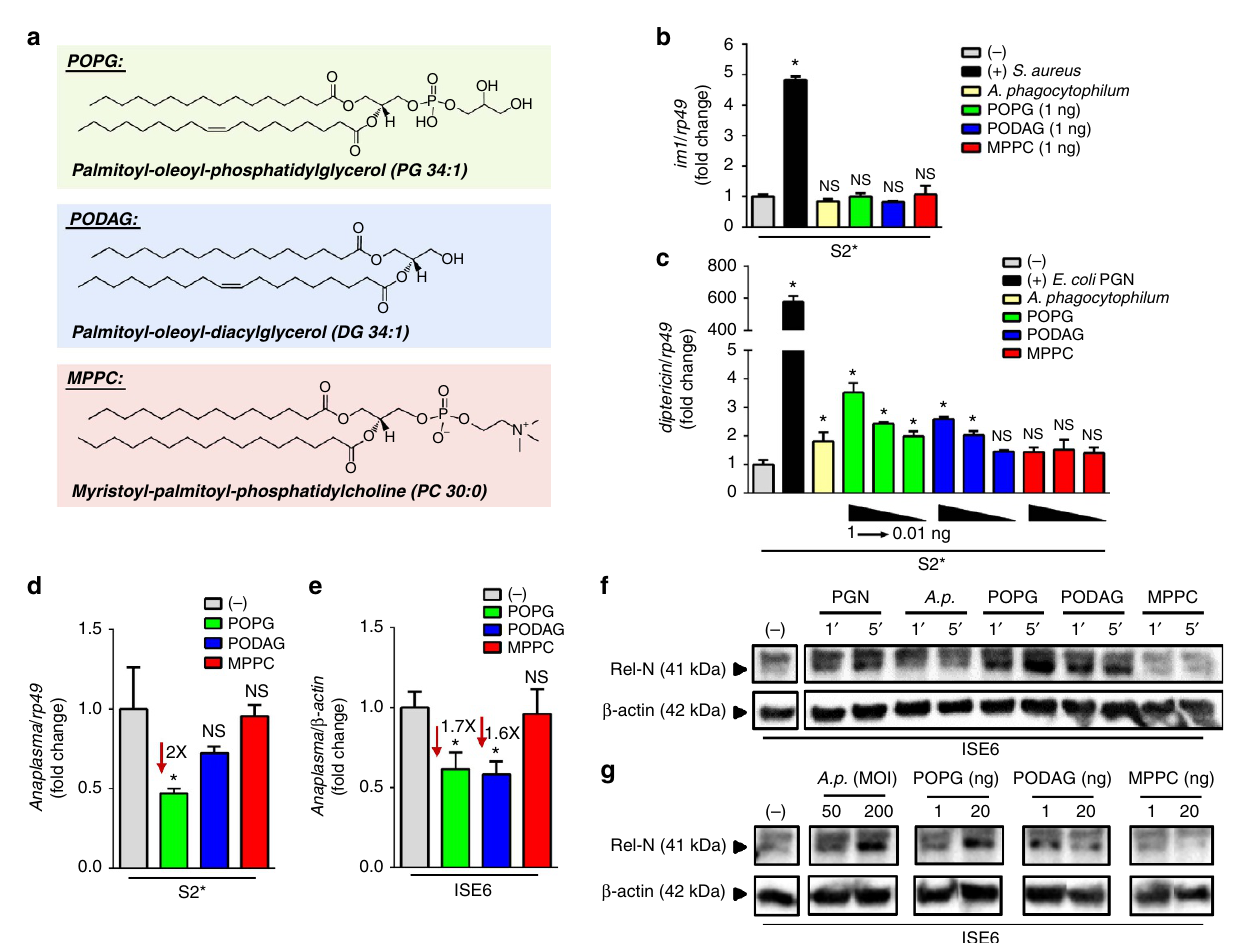
Figure 5 | Infection-derived lipids stimulate the IMD pathway. ( a ) Reference structures for the three lipids used in stimulation studies: (1) POPG, (2) PODAG and (3) MPPC. ( b , c ) Triplicate samples of 1 (cid:3) 10 6 S2* cells were primed with 20-hydroxyecdysone (1 m M) and stimulated with 0.01–1ng of indicated lipids, A. phagocytophilum (MOI 50) and positive controls for the Toll pathway ( S. aureus ) and the IMD pathway ( E. coli peptidoglycan). Quantitative PCR (qPCR) quantifying diptericin and im1 transcripts are shown. ( d ) Triplicate samples of 1 (cid:3) 10 6 S2* cells or ( e ) Five replicates of 1x10 5 ISE6 cells were incubated with 1ng of indicated lipids before A. phagocytophilum infection at MOI 50. Bacterial load was quantified by qPCR and normalized to either rp49 ( Drosophila ) or b - actin (ISE6 tick cells). Data are represented as the mean ± s.e.m. Analysis of variance-Dunnet. * P o 0.05. NS, not significant. ( (cid:2) ), non-stimulated. ISE6 (1 (cid:3) 10 6 ) cells were stimulated with ( f ) diaminopimelic-type peptidoglycan (PGN) (10 m g/ml), A. phagocytophilum (MOI 50) and indicated lipids (1ng) at indicated times or ( g ) the indicated ranges of A. phagocytophilum and lipids for 15min. Lysates were probed against an I. scapularis Relish polyclonal antibody (Rel-N 41kDa). b -Actin (45kDa) was used as a loading control. ( b – e ) Data are representative of 3–5 biological replicates, as indicated, and two technical replicates. ( f – g ) Western blots (WBs) shown represent one of three biological replicates. See also Supplementary Figs 5, 11 and 12 and Supplementary Tables 2 and